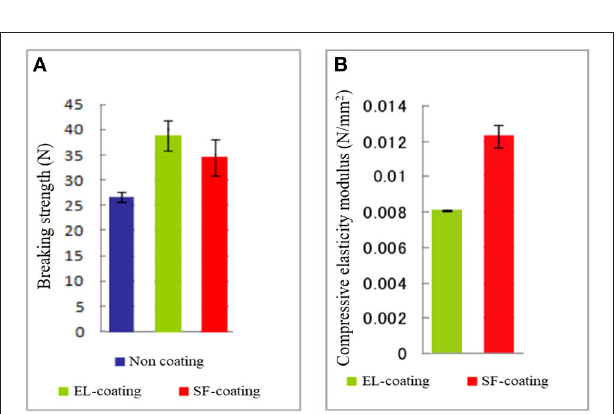
FIGURE 4 | (A) Circumferential tensile strengths determined for non-coated, silk fibroin (SF)-coated and elastin (EL)-coated SF knitted grafts. (B) Circumferential compressive elastic modulus of the EL and SF-coated SF grafts. We could not measure the compressive elastic modulus of non-coated SF graft because it collapsed immediately.